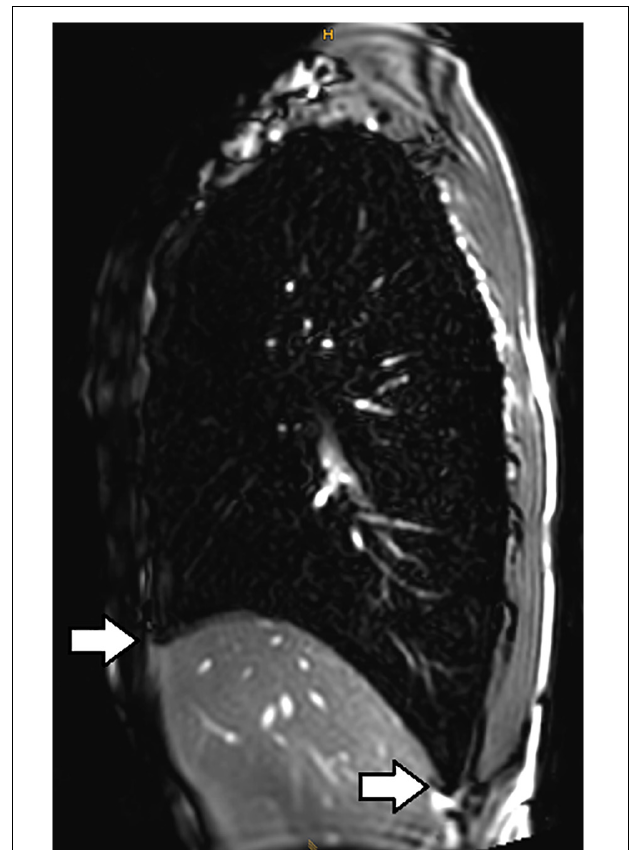
FIGURE 1 | Subxiphoidal and costodiaphragmatic recessus (marked with white arrows) filled with air during glossopharyngeal insufflation.